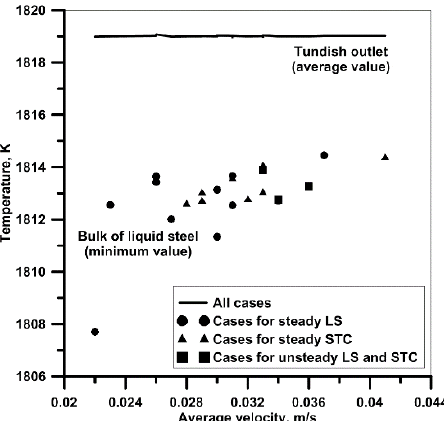
Figure 8. Liquid steel temperature for all considered tundish variants and steady state conditions.